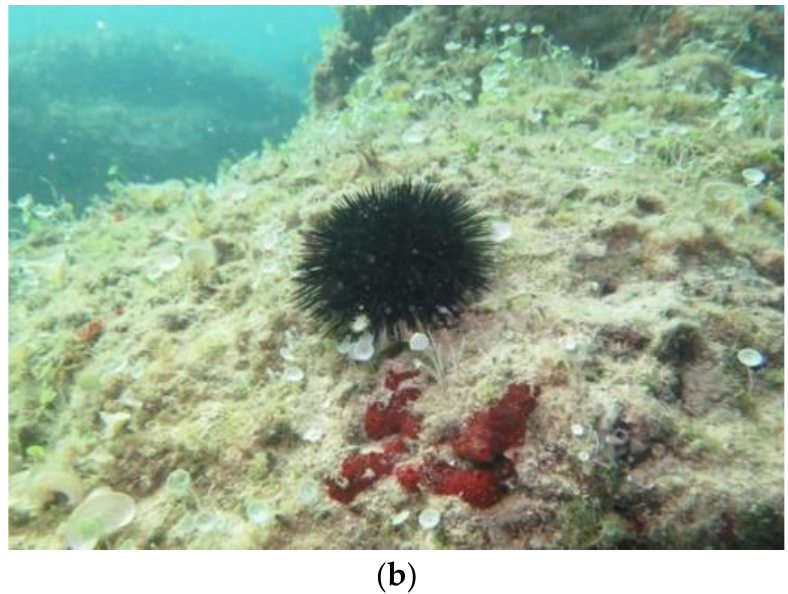
Figure 2. Photos of sea urchin from the Apulia region (southern Italy). Paracentrotus lividus ( a ) is also commonly referred to as the “edible female hedgehog”. The “male” or “black” hedgehogs ( b ) are none other than species of Arbacia Lixula . In Puglia, although the same applies to many other Mediterranean countries and to the parts of Spain and France bordering the Atlantic, the hedgehog that is harvested and consumed is the Paracentrotus Lividus , otherwise called “purple hedgehog” for the widespread presence, in its populations, of specimens whose spines show, precisely, a color tending to violet. Source: photos provided by Meliadò Eleonora, 2021, project “TuGePlAl” funded by the Apulia region (Appendix A).